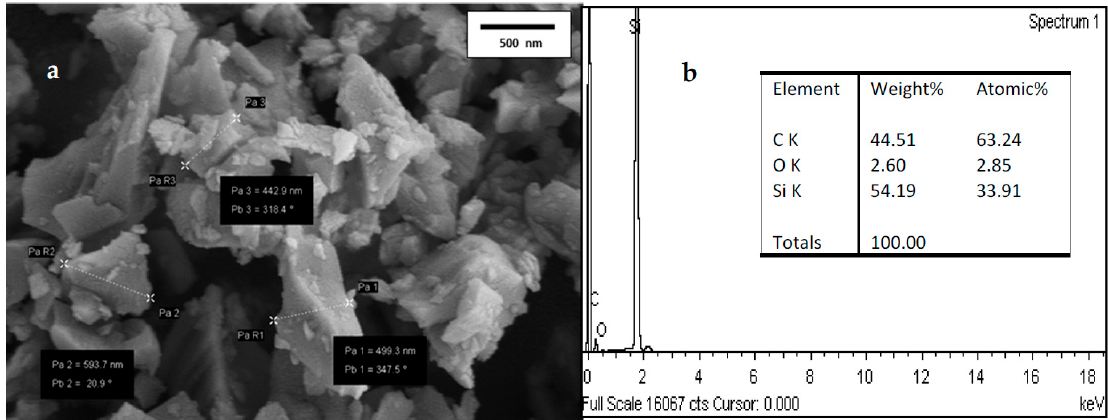
Figure 1. 3C-SiC face-cantered cubic crystal. Blue and black ball are the silicon and carbon, respectively.